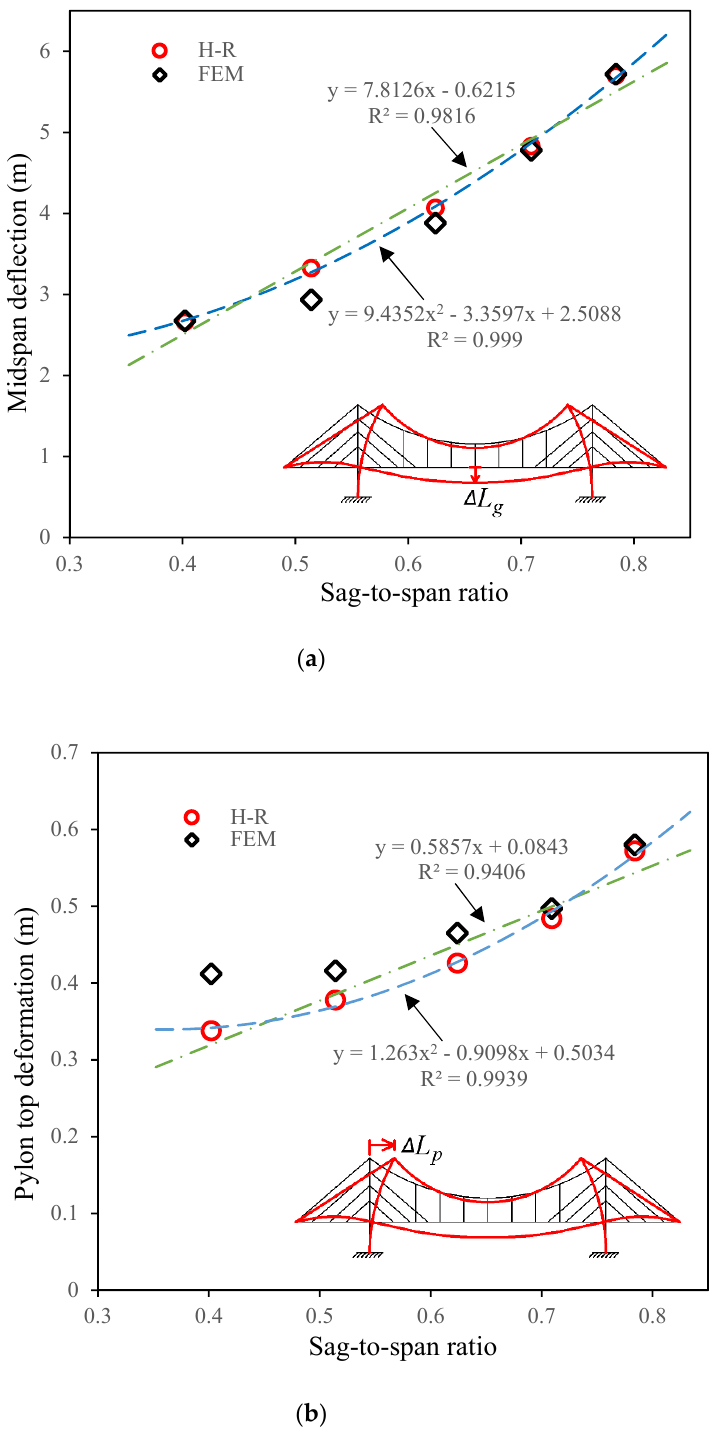
Figure 10. Impact of sag-to-span ratio on deformation. ( a ) Midspan deflection changing with sag-to-span ratio. ( b ) Pylon top deformation changing with sag-to-span ratio.